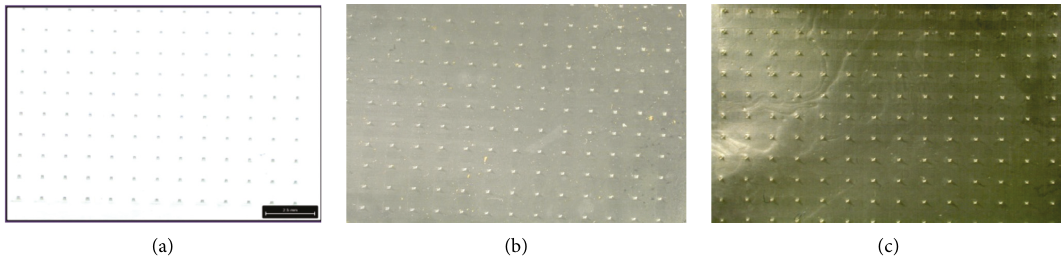
Figure 7: (a) PDMS mould optical microscopic image, (b) blank patch optical microscopic image, and (c) Bacopa monnieri loaded microneedle